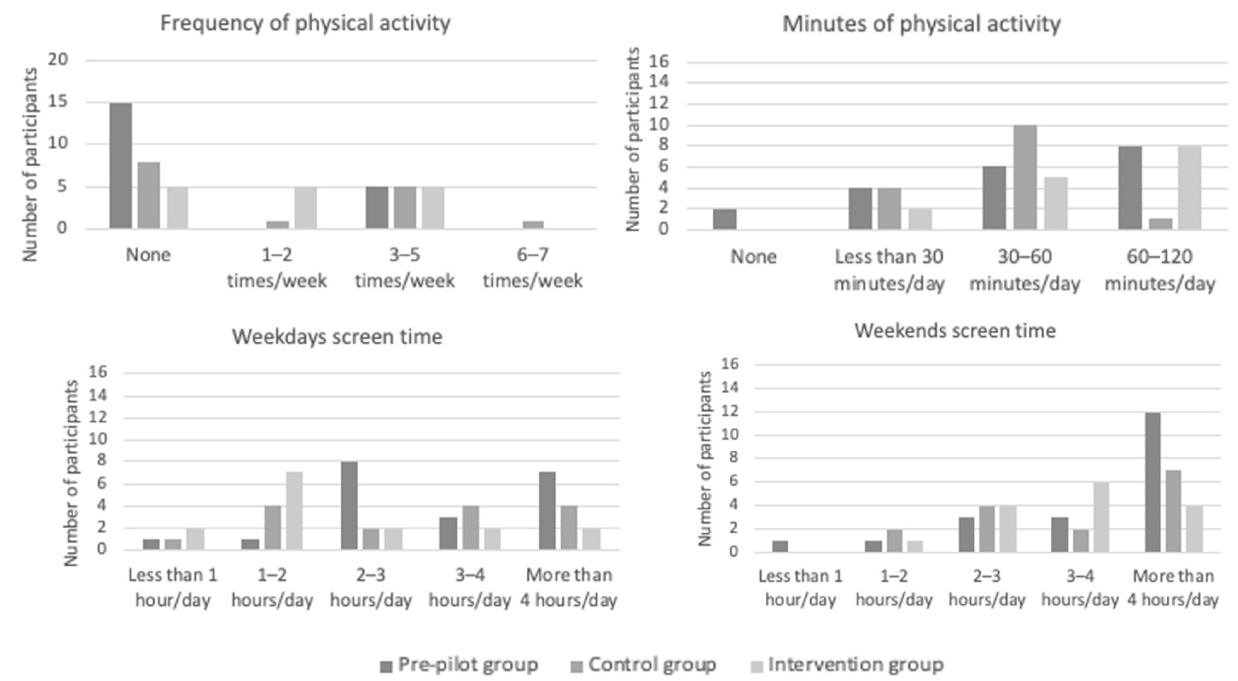
Figure 3. Baseline health behaviors in terms of physical activity and screen time.